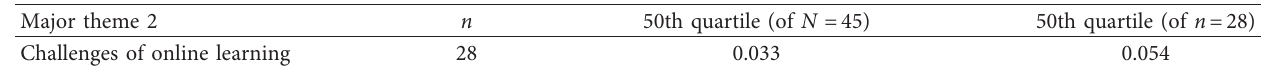
Table 5: 50th quartiles for challenges of online learning.